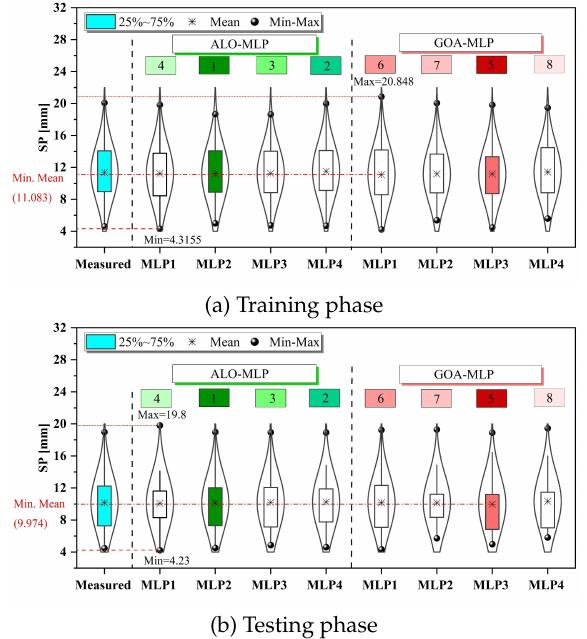
Fig. 12. Violin plots for all developed models